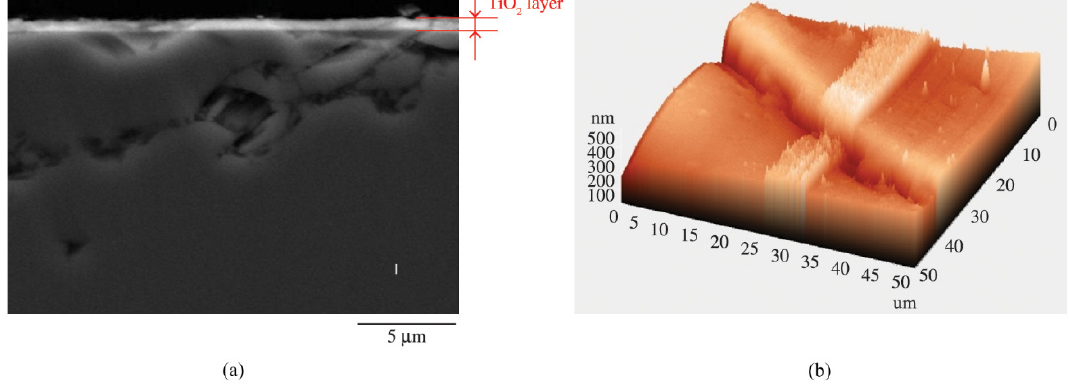
Figure 6. (a) MEV and (b) AFM of double titanium cage deposited sample at 370°C - 2,0h – magnification 5000X.